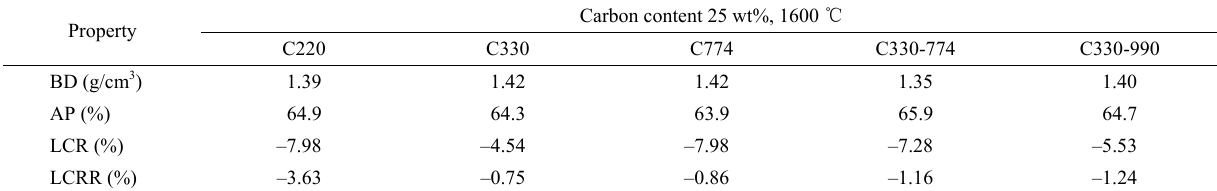
Table 2 Physical properties of porous alumina specimens with different types of carbon black